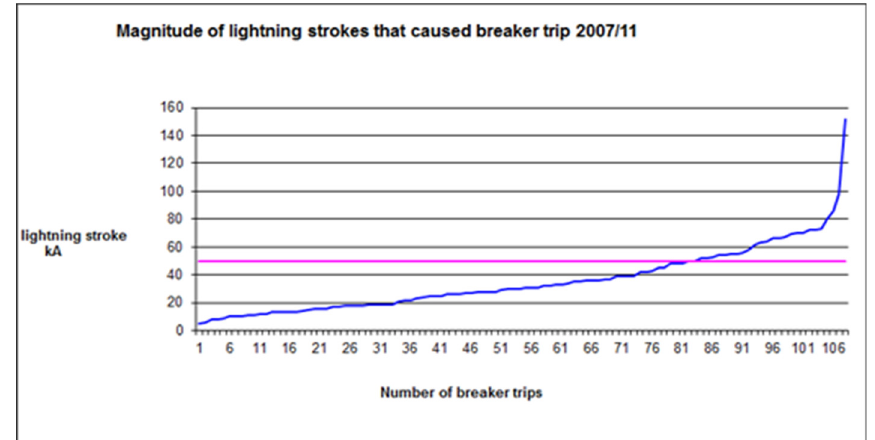
Figure 11. The incident of breaker interruptions vs. stroke magnitude.